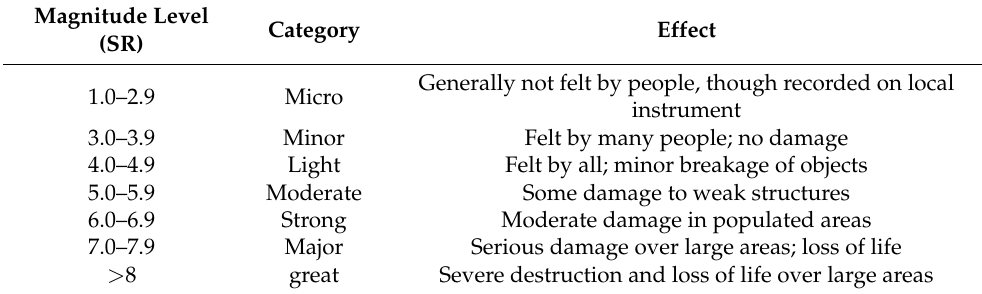
Table 1. Ritcher scale of earthquake